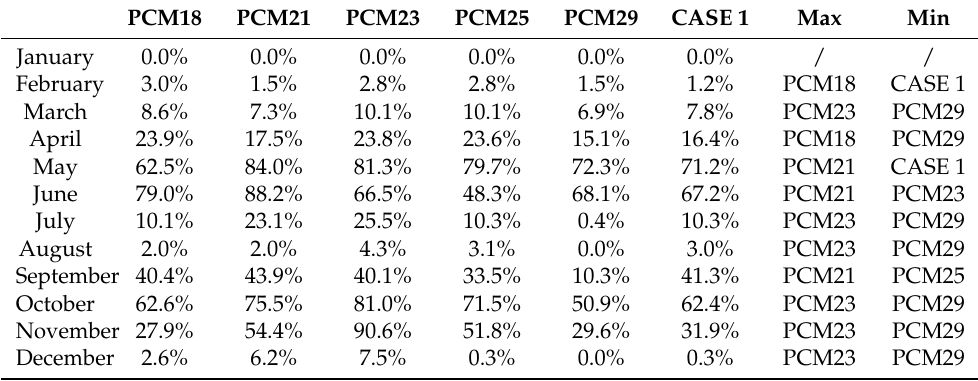
Table 7. Annual hours and percentage of annual hours in which the indoor air temperature is in the range of 20–26 ◦ C in free-floating conditions, as a function of the PCM melting